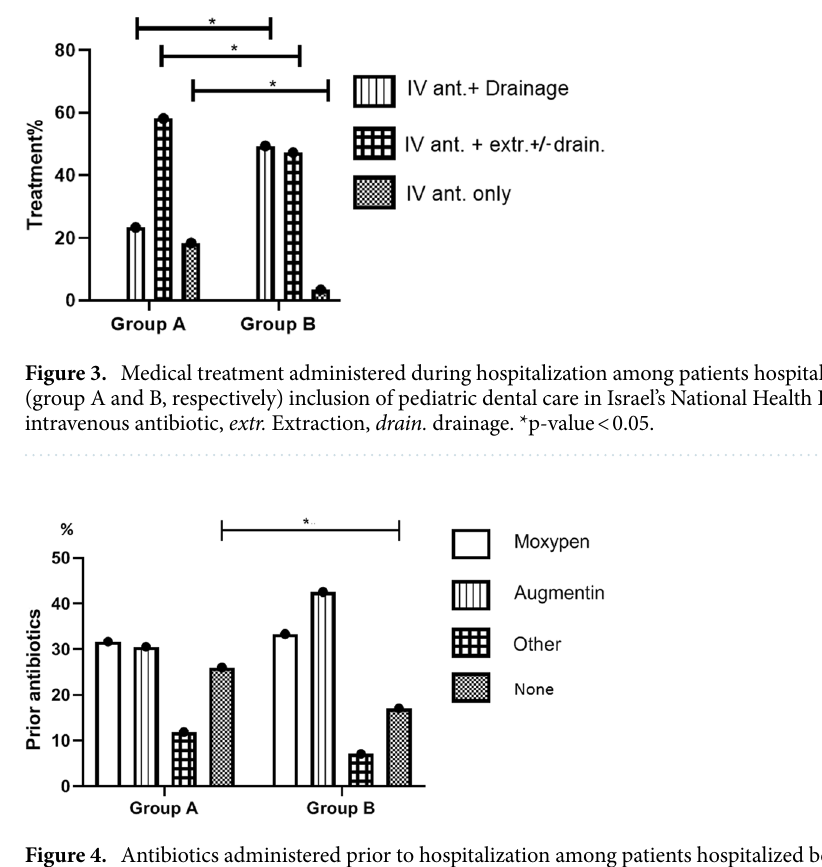
Figure 4. Antibiotics administered prior to hospitalization among patients hospitalized before and after (group A and B, respectively) inclusion of pediatric dental care in Israel’s National Health Insurance Law. *p-value <